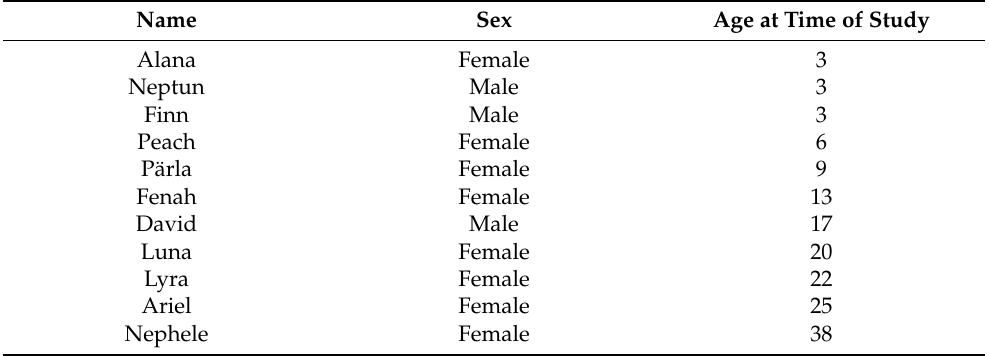
Table 1. Eleven Bottlenose dolphins ( Tursiops truncatus ) at Kolmårdens Djurpark included in the